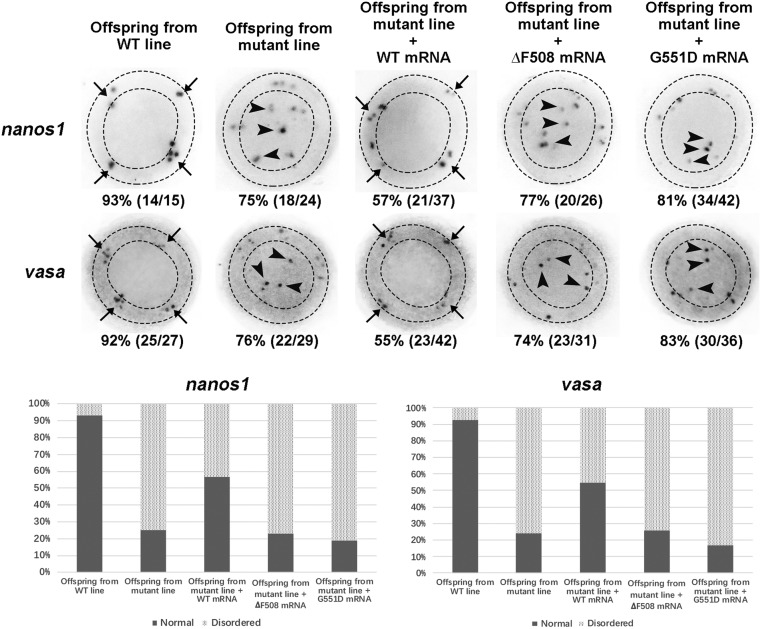
CFTR mutants with loss of ion channel function fail to recover PGCs development. Analysis of localization of nanos1/vasa positive cells in embryos by WISH at 50% Epiboly stage with top view.